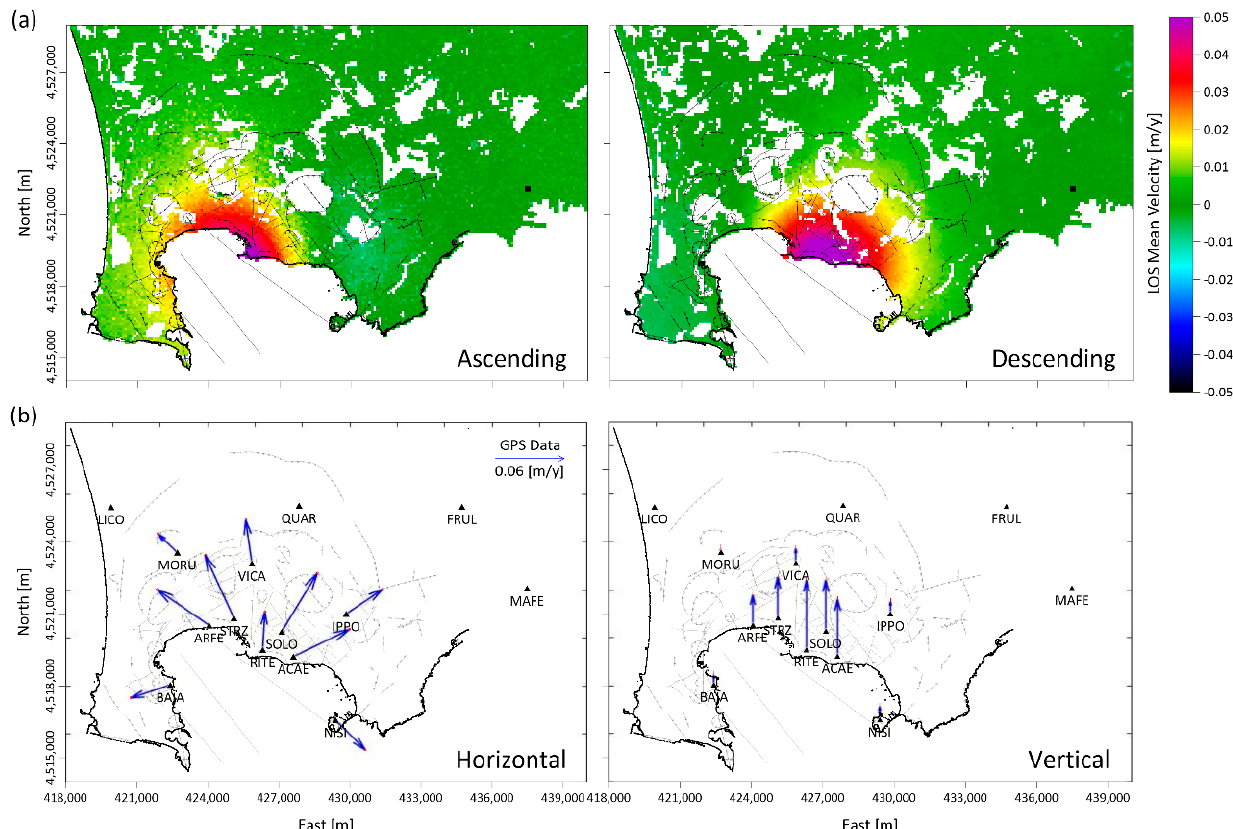
Figure 2. Ground deformation data. ( a ) The 2011–2013 LOS mean deformation velocity retrieved along ascending (left panel) and descending (right panel) orbits from CSK SAR images (data from [15]). The black lines indicate the faults and outer/inner rims of the CF caldera; the reference point is marked by a black rectangle. ( b ) Blue arrows indicate 2011–2013 horizontal (left panel) and vertical (right panel) GPS deformation velocity components (calculated from [11]) of the considered stations: RITE, MORU, VICA, ARFE, IPPO, ACAE, BAIA, SOLO, STRZ, NISI; all the measurements refer to MAFE station. The black triangles represent the INGV permanent GPS network taken from [11].